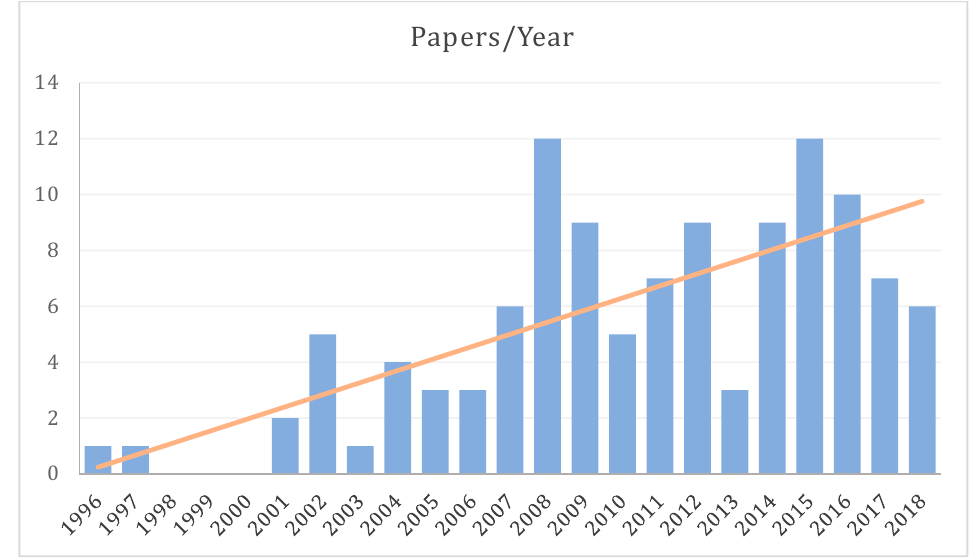
Figure 1 . Histogram of the number of papers published per year on spinal fMRI, since its inception in 1996.